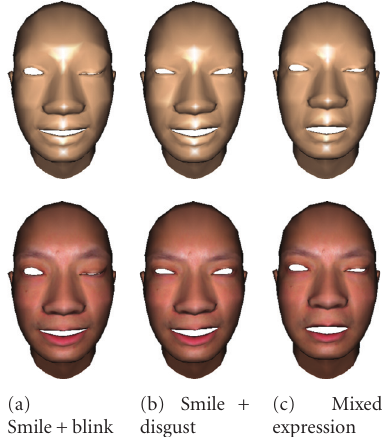
Figure 4: Expressions are blended by changing weight for each expression. (a) Blending smile (1.0) and blink (1.0), (b) blending smile (1.0) and disgust (0.5), (c) blending all expressions : anger (0.3) + blink (0.6) + disgust (0.3) + smile (0.1) + surprise (0.4).